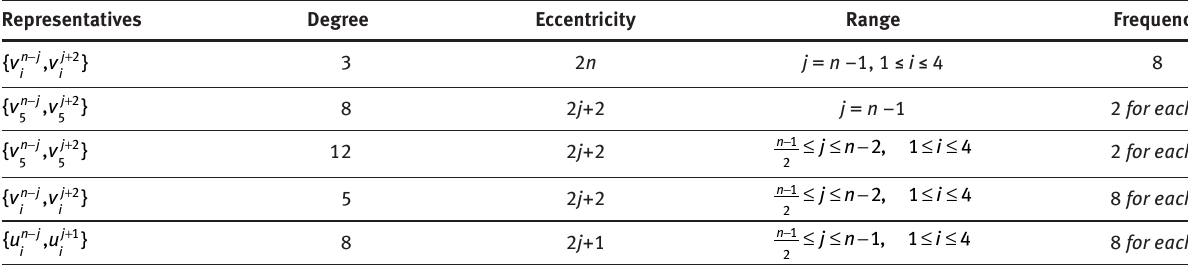
Table 2: Eccentricity and degree based vertex partition of FCC ( n ) for n ≡ 1(mod2)